Question: Does the plotted quantity increase or decrease?
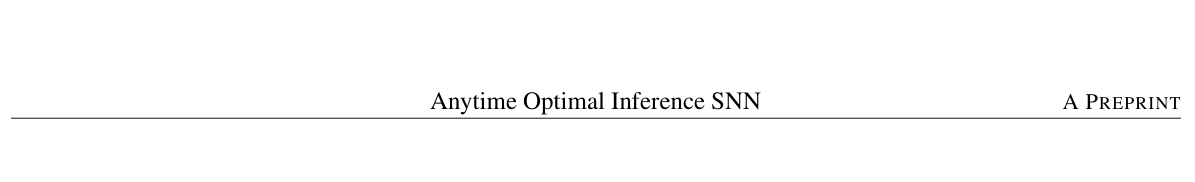
Answer: decreasing